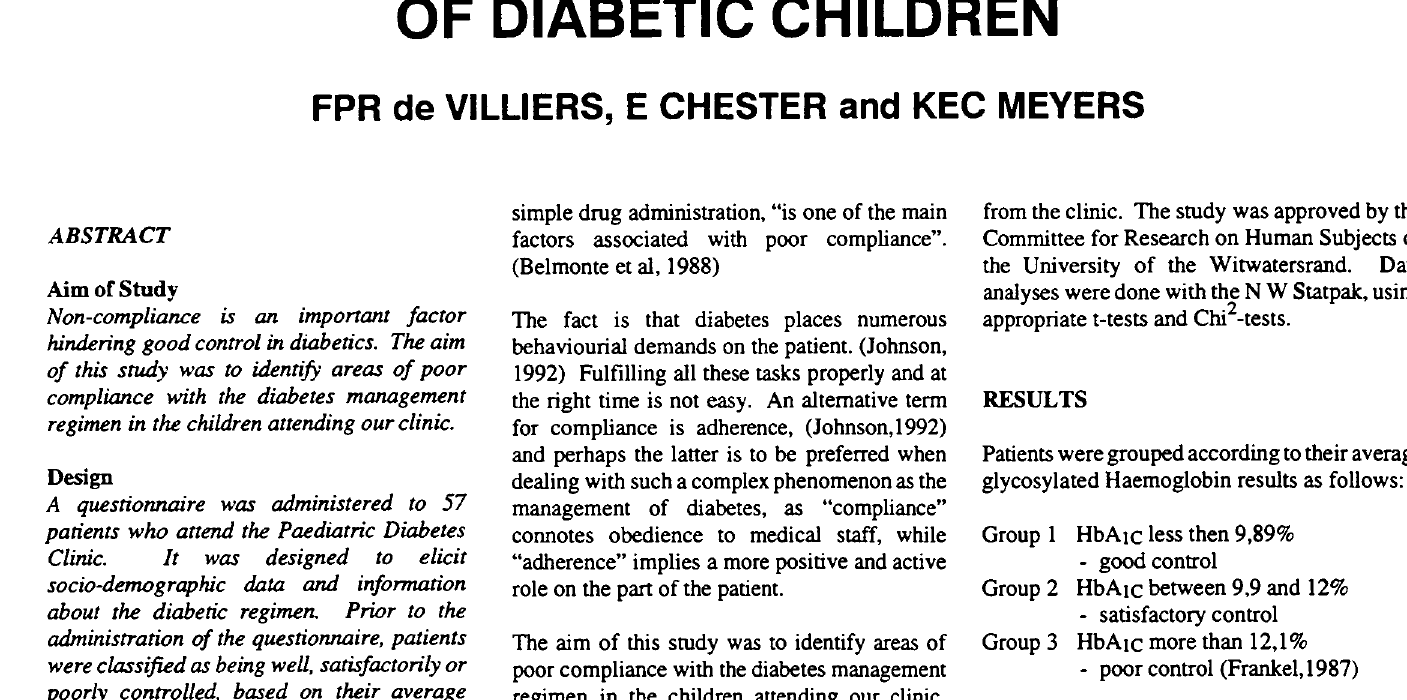
Table 1 indicates selected demographic data, including the age, sex, race and socio-economic status of the